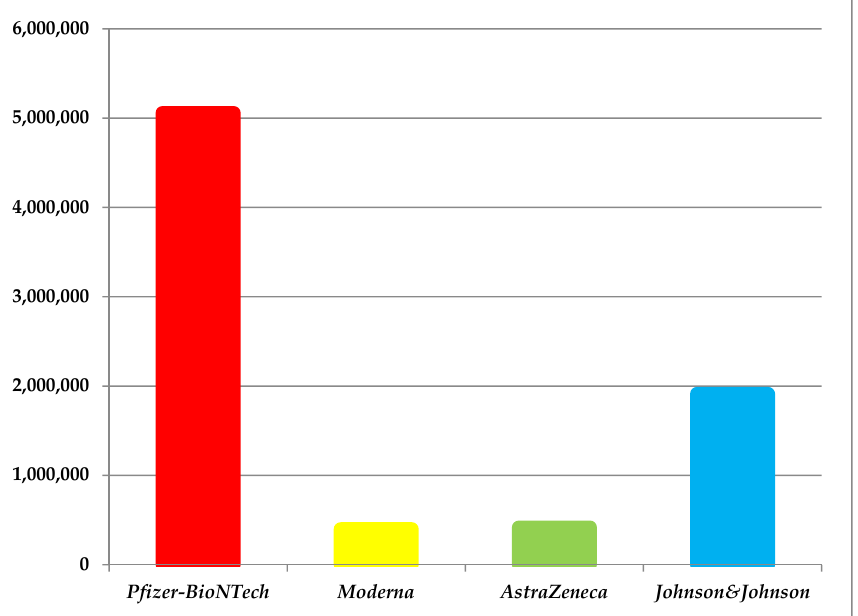
Figure 2. Graphic showing the total number of Romanian individuals who completed the vaccination scheme.